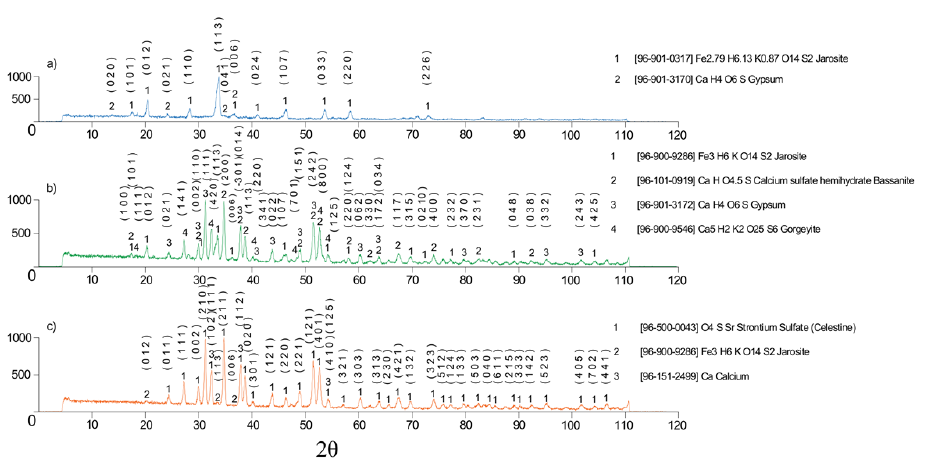
Figure 8. X-ray diffraction spectra for the doped jarosite-type compounds: ( a ) JKCa; ( b ) JKCa2; and ( c ) JKAll.